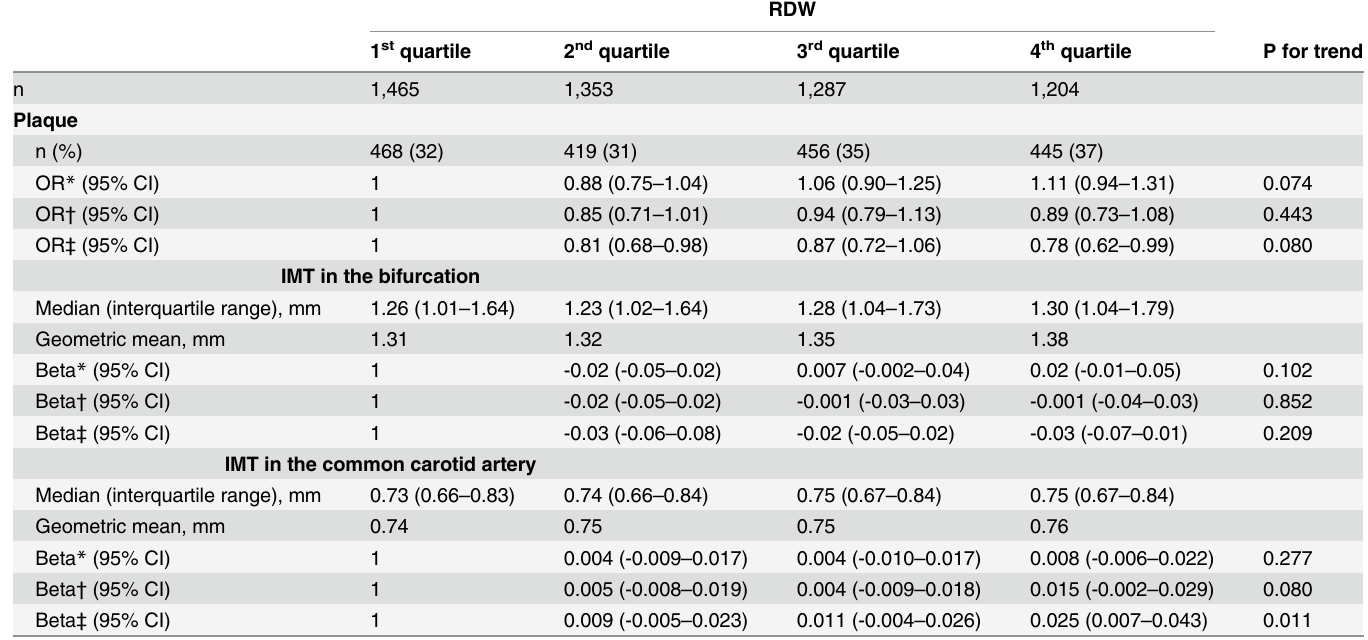
Table 4. Association between quartiles of red cell distribution width (RDW) and presence of carotid plaque and carotid intima – media thickness. RDW 1 st quartile